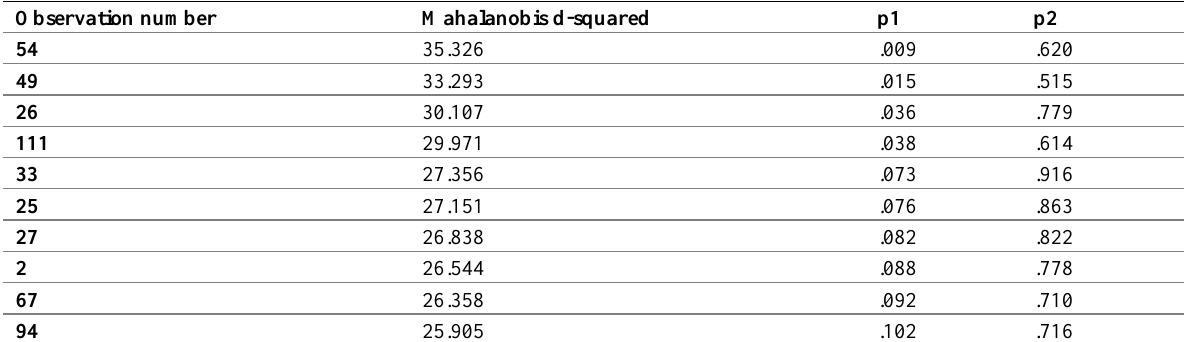
Table 3 : Results of Outlier